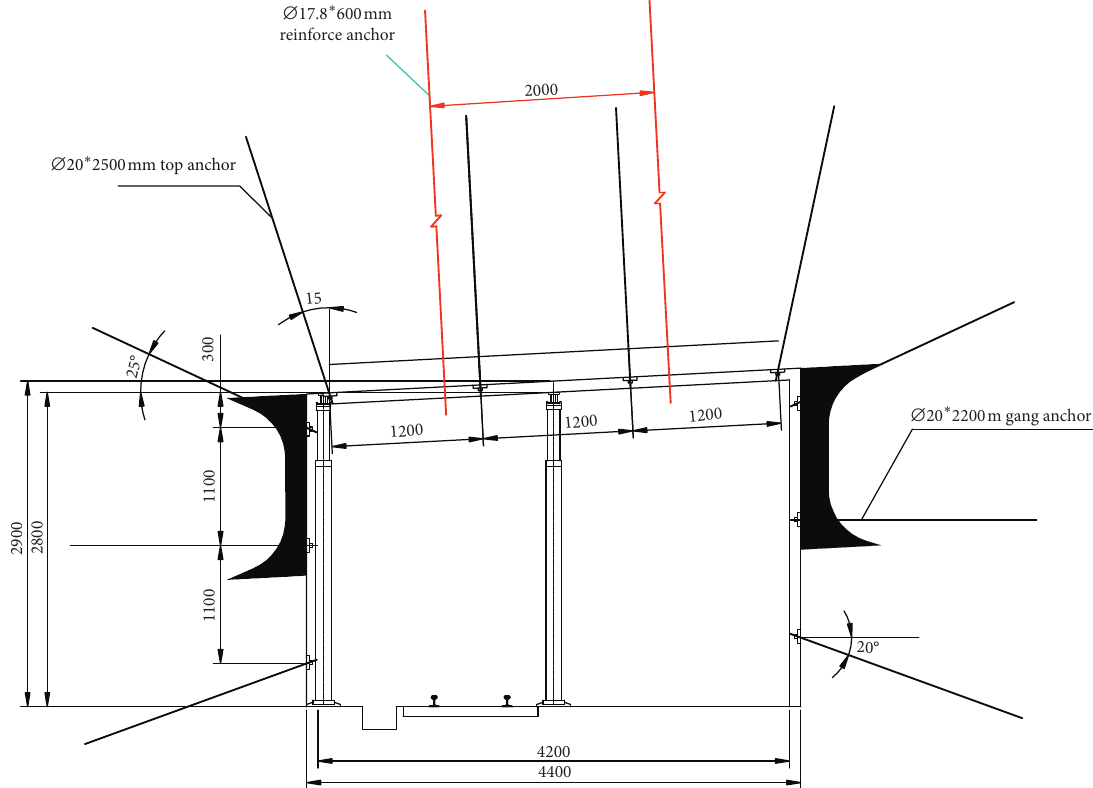
Figure 20: Sectional view of anchor cable reinforced support